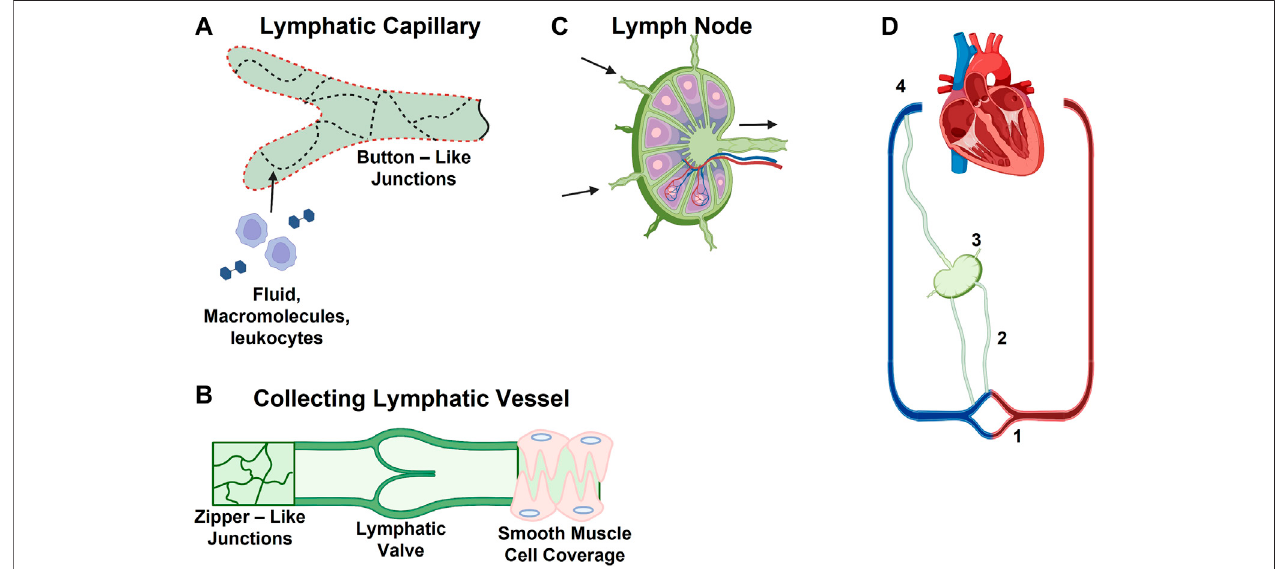
FIGURE 1 | Schematic of Lymphatic Vessel Transport Properties. (A) Discontinuous basement membrane (red dashed line) and button junctions (dotted lines) allow for lymphatic capillaries to absorb interstitial solutes, macromolecules, and immunecells. (B) Collecting vesselscontain zipper-like junctions (continuous lines) and unidirectional valves. (C) Schematic of lymph node with multiple afferent and a single efferent vessel. (D) Lymphatic vascular system consists of (1) lymphatic capillaries, (2) collecting lymphatic vessels, (3) lymph nodes, and (4) the thoracic duct and right lymphatic trunk.